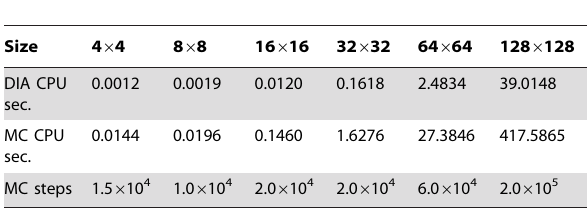
Table 1. Number of Monte Carlo (MC) steps.